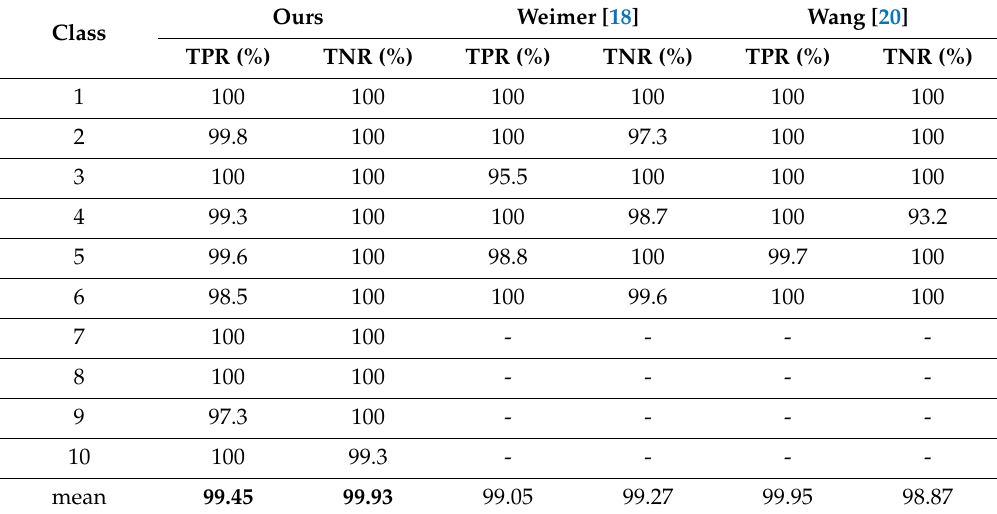
Table 4. True negative rate (TNR ) and true positive rate (TPR ) performance comparison.